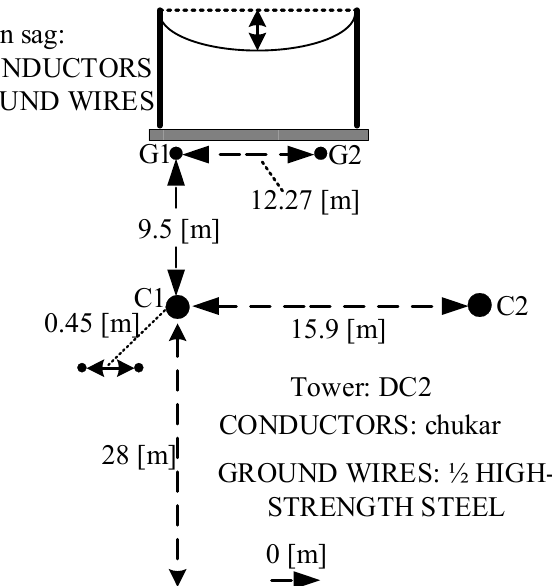
Figure 2. The structure of the overhead line tower of the Zhangbei flexible DC power grid. The bipolar DC system is taken as an example to analyze its fault traveling wave characteristics under a single-pole ground fault and double-pole ground fault. Figure 3 shows the fault network diagram of the system at the fault point, in which R f is the fault transition resistance.